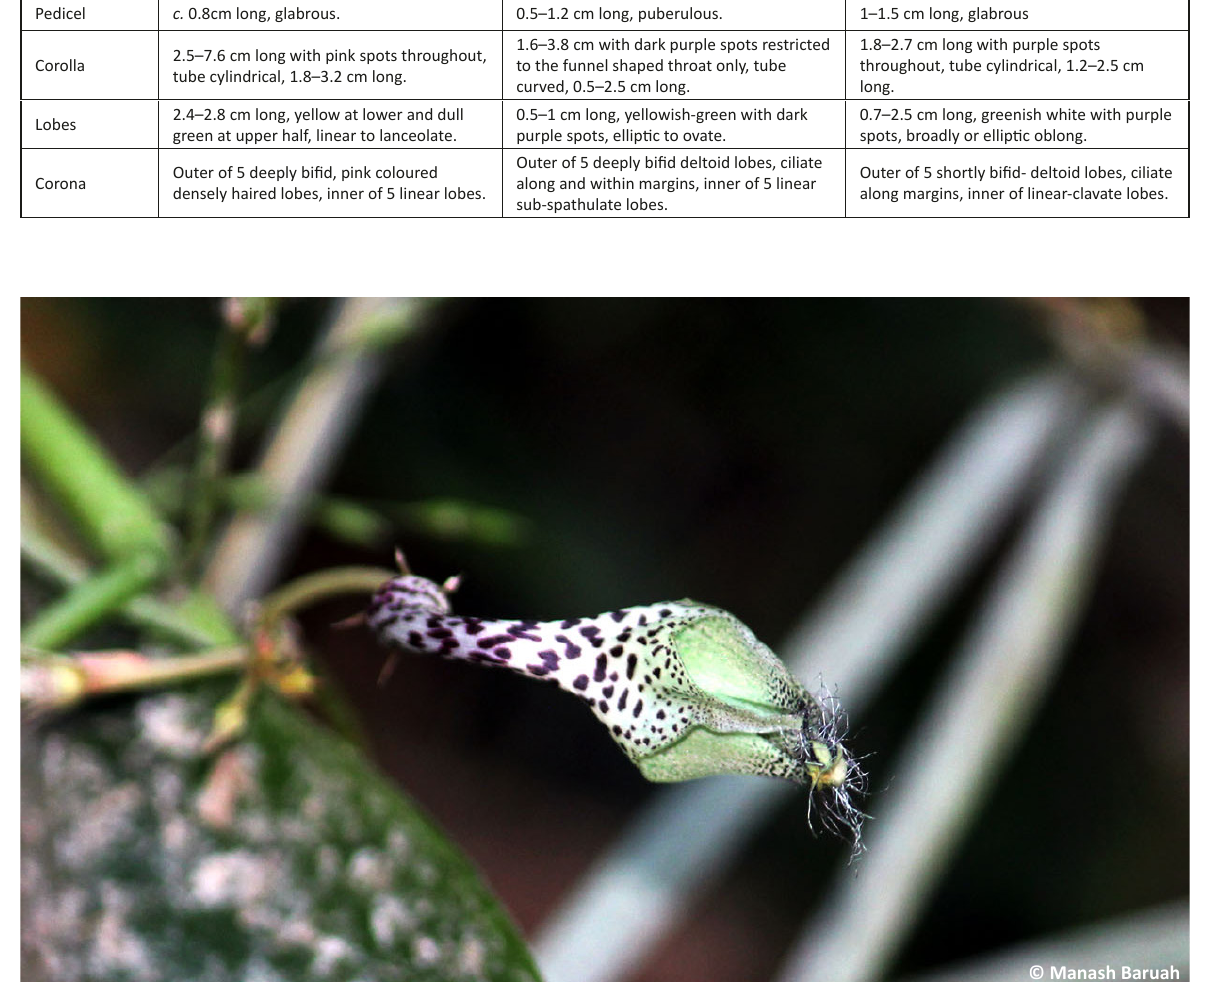
Image 3. A single flower of Ceropegia lucida